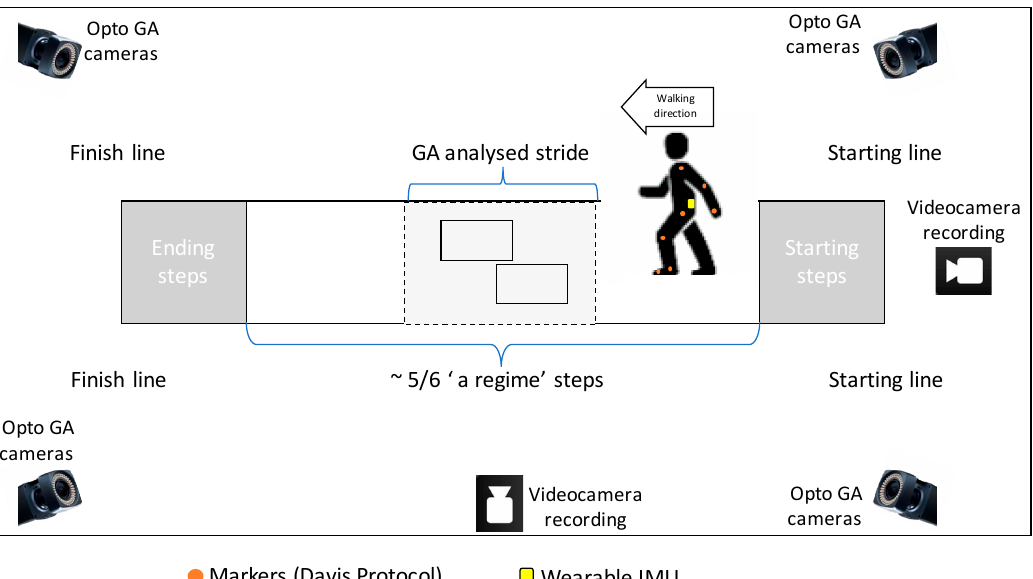
Figure 2. A validation setup of the laboratory for the analysis of wearable IMUs (Inertial Measurement Units) for GA (Gait Analysis). The walking path is segmented into the region where only wearable IMUs provide data about the straight steps and the area in which both optoelectronic systems and wearable IMUSs are collecting the same data (GA analyzed stride).